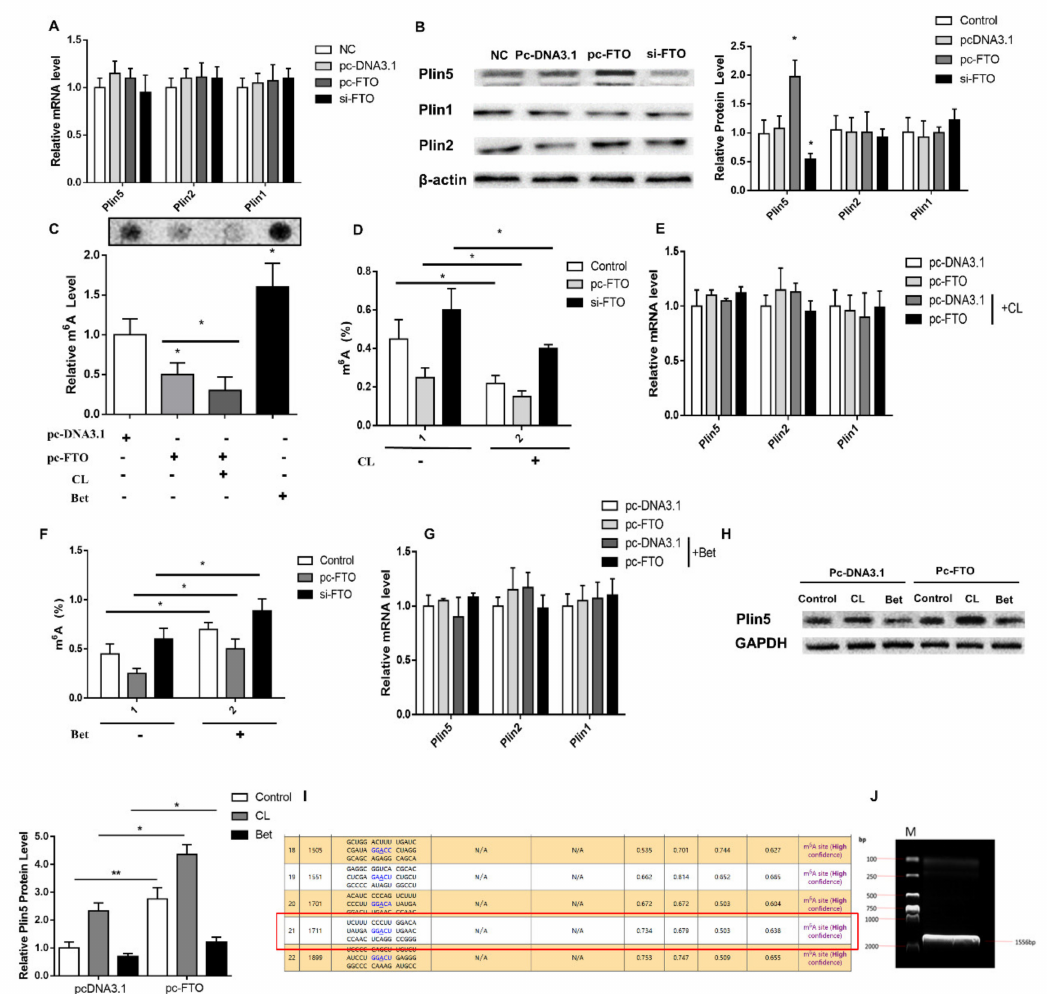
Figure 4. FTO up-regulates Plin5 protein expression by inhibiting the m 6 A methylation of Plin5. The effect of FTO interference or overexpression in vitro on: ( A ) Plin family mRNA expression and ( B ) Plin family protein levels. ( C ) The relative M 6 A levels of pig adipocytes in vitro treated with CL and Bet after overexpression or interference with FTO. ( D ) The total M 6 A level of CL − treated pig adipocytes in vitro after overexpression or interference with FTO. ( E ) Plin family mRNA expression in CL − treated pig adipocytes in vitro after overexpression or interference with FTO. ( F ) The total M 6 A level of Bet-treated pig adipocytes after overexpression or interference with FTO. ( G ) Plin family mRNA expression in Bet-treated pig adipocytes in vitro after overexpression FTO. ( H ) Plin5 protein expression in pig adipocytes in vitro treated with CL and Bet after overexpression FTO. ( I , J ) Plin5 3 (cid:48) UTR end M 6 A site mutation vector construction. n = 4 for each group of cell samples, values are means ± SD. vs. control group, * p < 0.05, ** p <